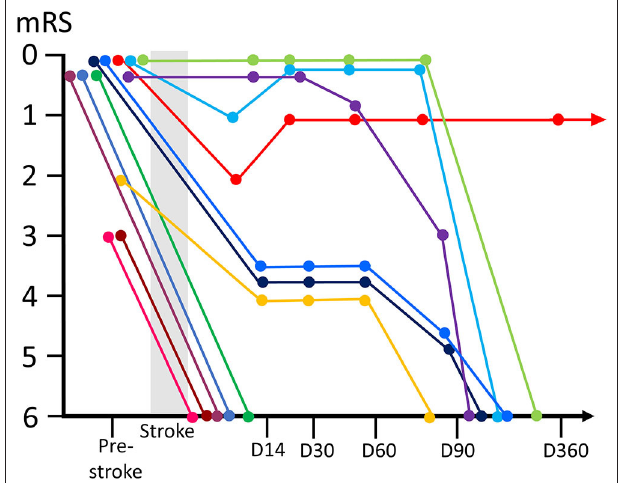
FIGURE 1 | Time courses of the clinical outcome (modified Rankin Scale; mRS) and prognosis of malignancy patients with EVT. Clinical outcome trajectories (from pre-stroke period till death) for individual patients are represented using different colors. EVT, endovascular